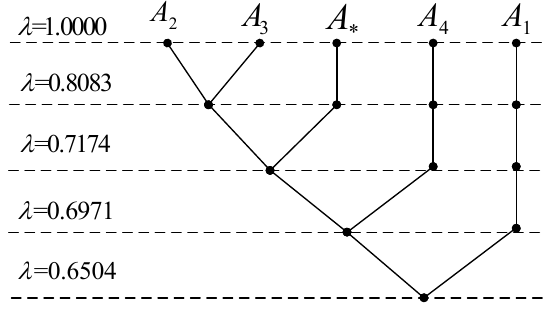
Figure 3. The clustering process of the person subjected to execution A i ( i = 1,2,3,4, ∗ ) . The clustering results of the two clustering algorithms are shown in Table 2. Table 2. The clustering results obtained by different algorithms. Clusters